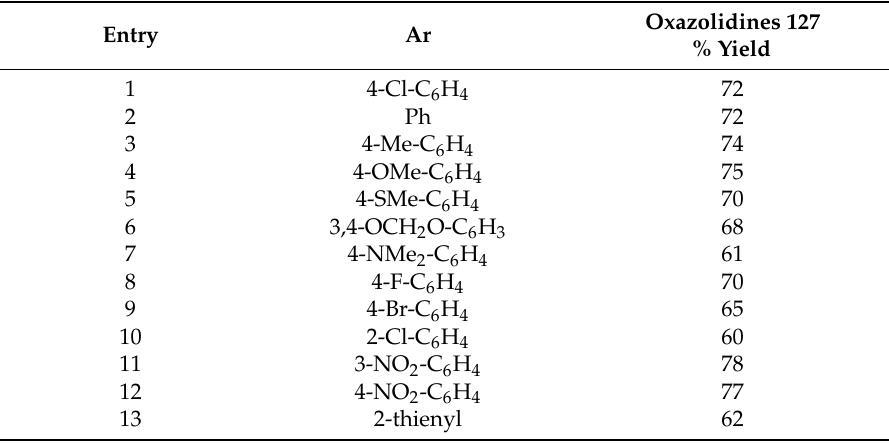
Table 17. Cycloaddition of azomethine ylide 126 to aromatic aldehydes 2 (Scheme 31).